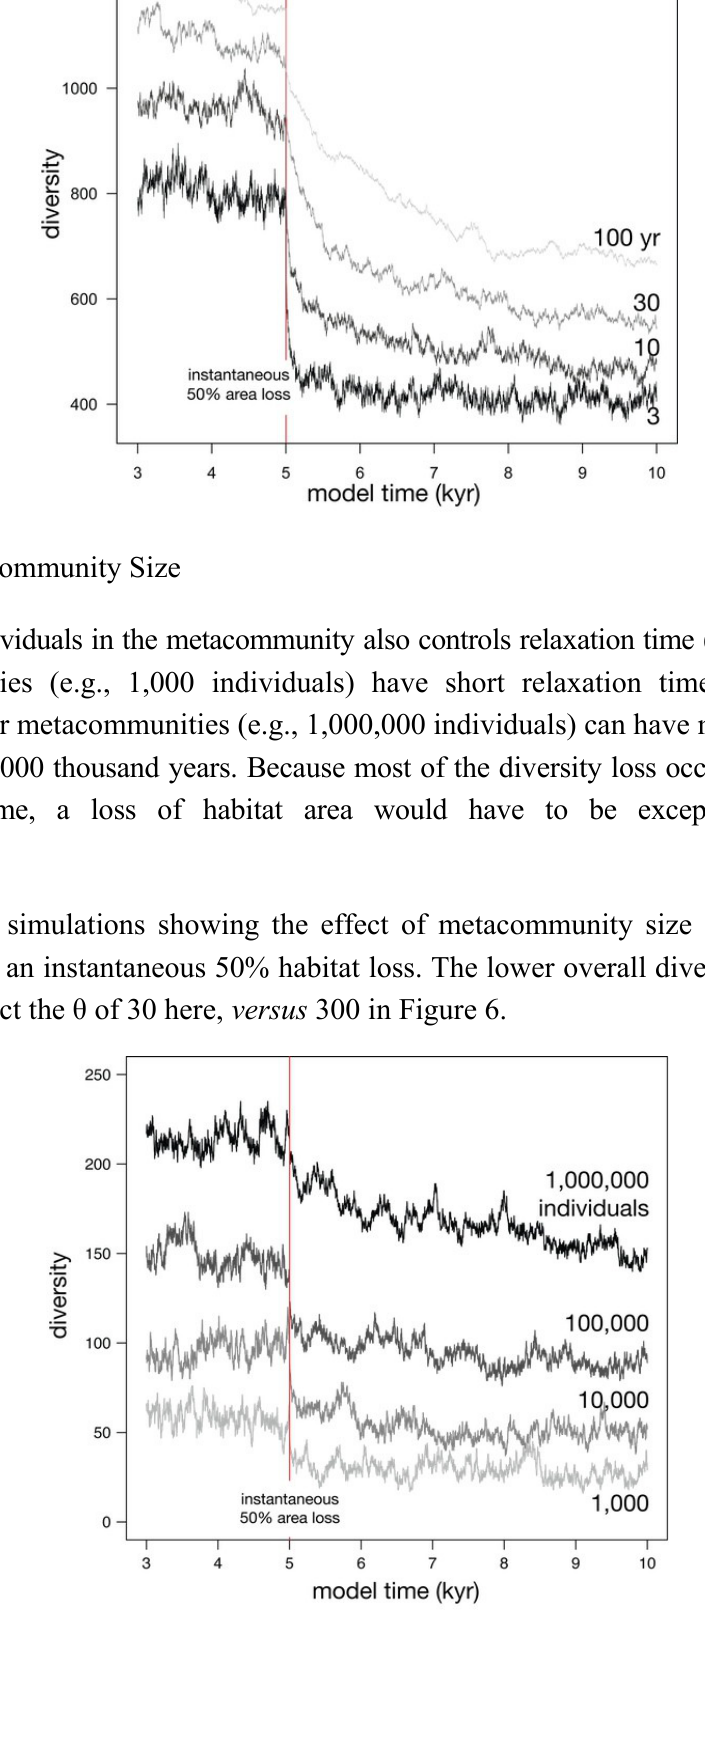
Figure 6. Four simulations depicting the effect of the average lifespan of individuals on diversity before and after an instantaneous 50% habitat loss.